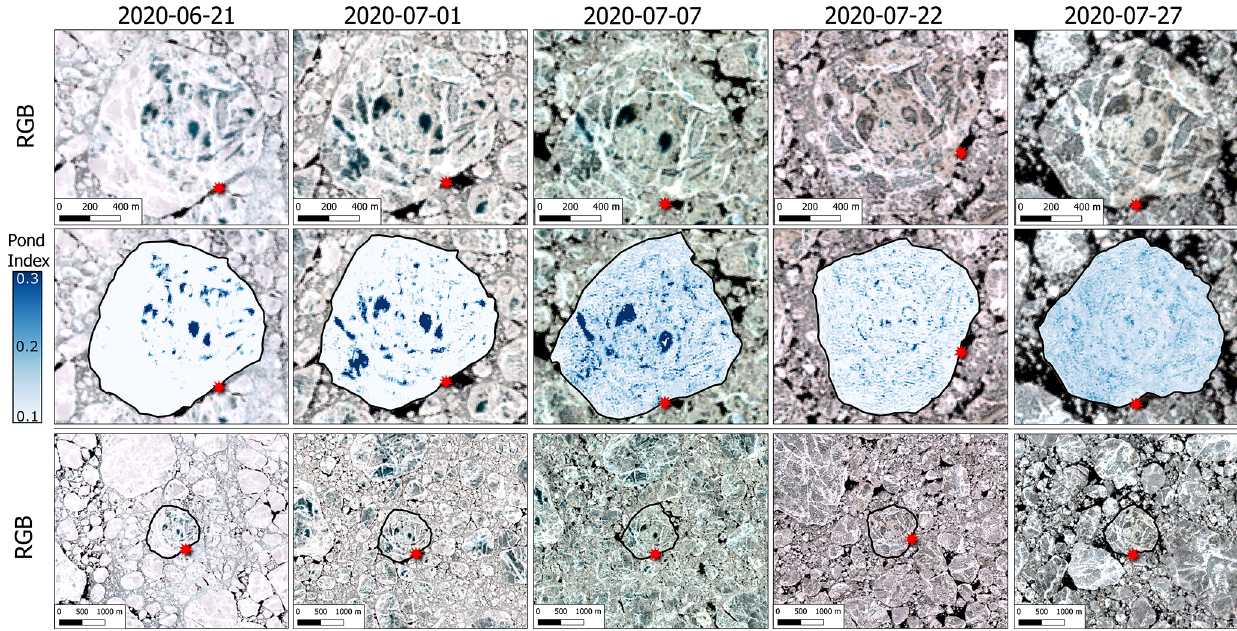
Figure 18. The top row shows the Sentinel-2 MSI true colour images of the MOSAiC floe obtained between 21 and 27 July 2020. The middle row shows an outline of the MOSAiC CO (black) and areas with classified melt ponds (pond index). The bottom row shows true colour images with the larger surrounding of the MOSAiC floe (black outline) and the temporal evolution of melt pond on the surface of neighbouring floes. The red star shows the position of Polarstern at the time of the satellite image